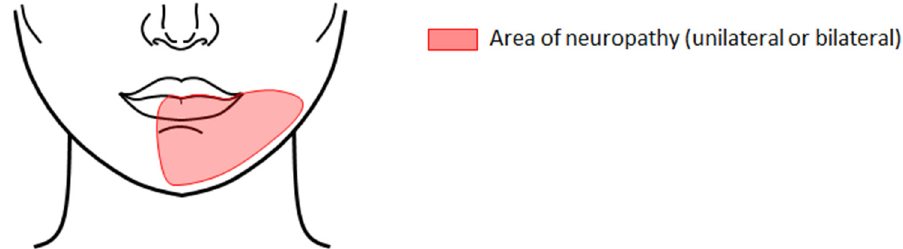
Figure 1. Area of sensory neuropathy in numb chin syndrome (adapted from Konotey-Ahulu, 1972 [17]).